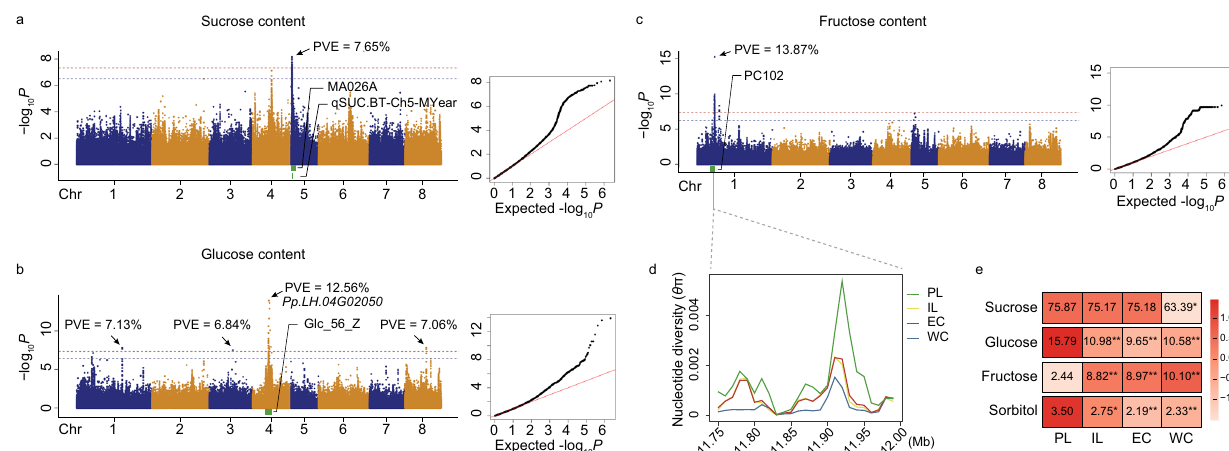
Fig. 4 Genetic loci associated with the content of sucrose, glucose, and fructose affecting peach fruit sweetness. GWAS results from analyses of data for sucrose ( a ), glucose ( b ), and fructose ( c ) content in 2017, respectively. The horizontal lines depict the Bonferroni-adjusted signi fi cance threshold (red) and Permutation threshold (blue) in the Manhattan plot. The indicated PVE (phenotypic variance explanation) value is for the lead SNP at the major locus for each trait. The green bar at the bottom of each Manhattan plot represents previously reported QTLs 27, 68, 129 overlapping the major loci of these three traits. d Reduced nucleotide diversity ( θ π ) in the speci fi c genome region, corresponding to the major locus of fructose content on Chr1, of the ILs, ECs, and WCs, as compared to PLs. e Representation of fruit sugar pro fi les in the different peach types representing the course of peach improvement (* P < 0.05, ** P < 0.01 in two-sided Student ’ s t -tests). Among the four examined sugars, only fructose content has been signi fi cantly elevated during peach improvement. The scaled value of sugar content is shown at the right